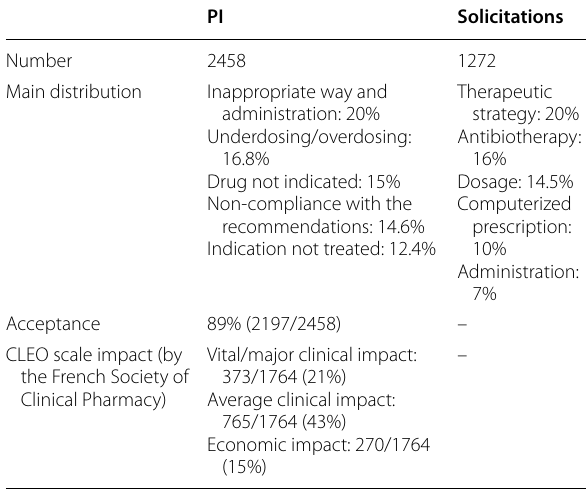
Table 1 Main elements of pharmaceutical interventions (PI) analy‑ sis and solicitations